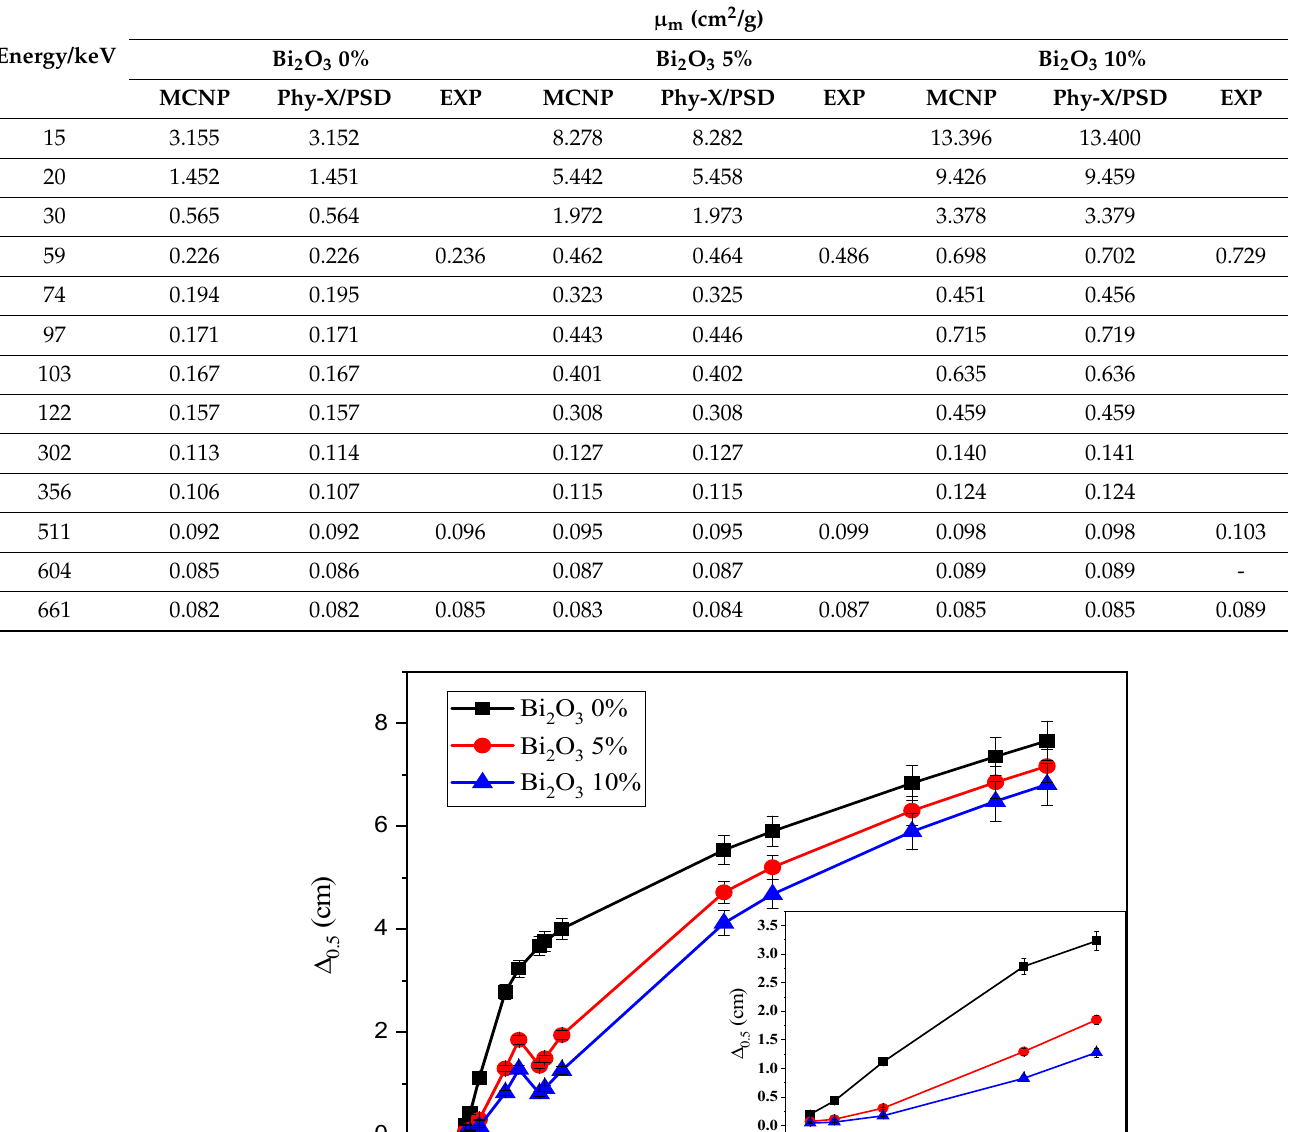
Table 2. The mass attenuation coefficient simulated by MCNP-5 code XCOM online software.